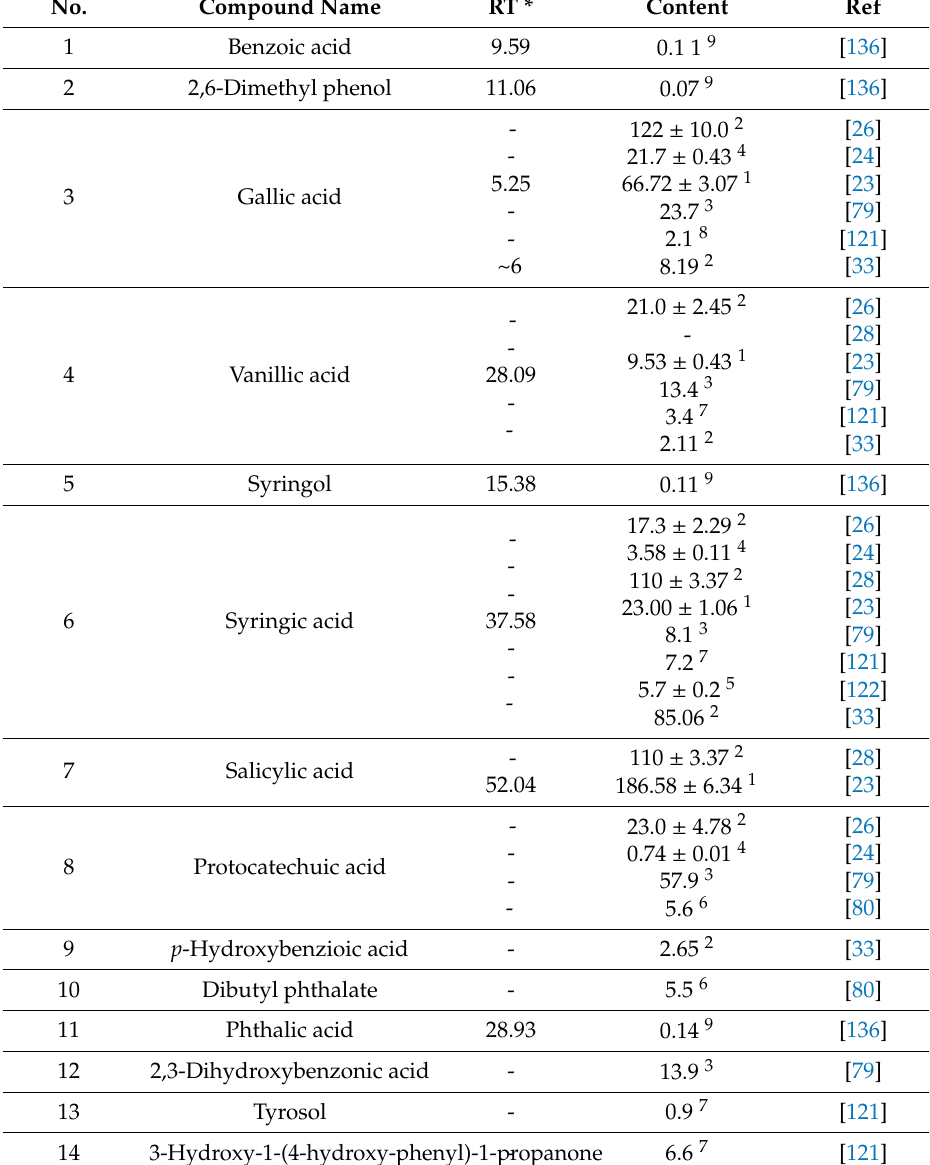
Table 3. Di ff erent identified hydroxybenzoic acids in green walnut husk along with their retention time and